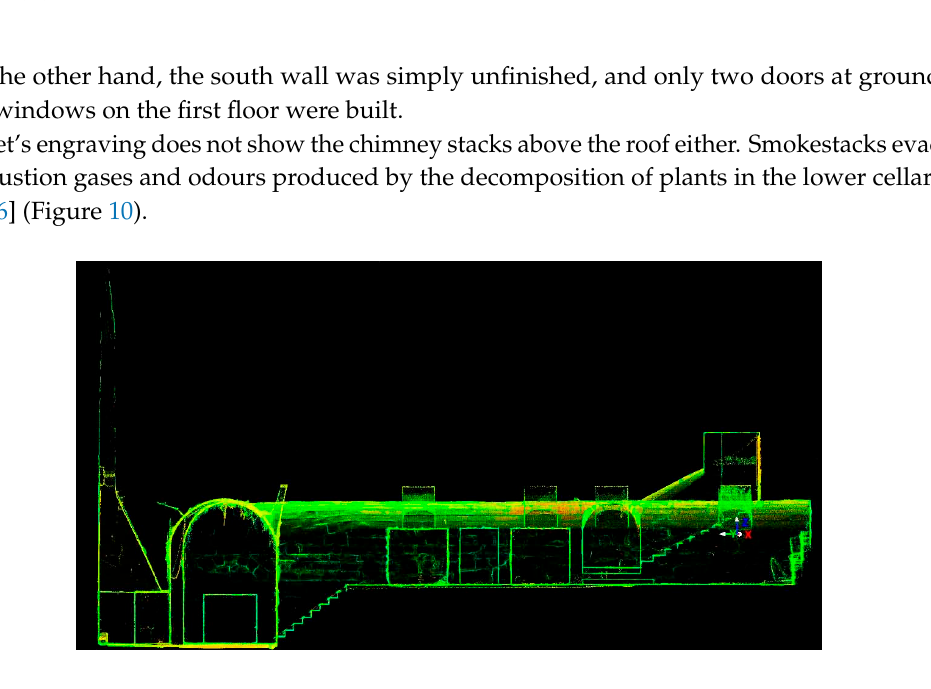
Figure 11. Francisco de Mora, ca. 1585: Plano de la huerta del Monasterio de San Lorenzo de El Escorial . ( a )